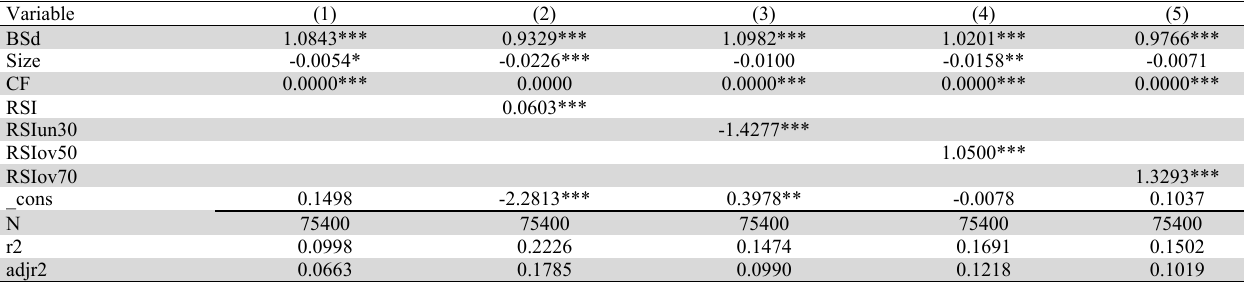
Fama-MacBeth estimation results from the